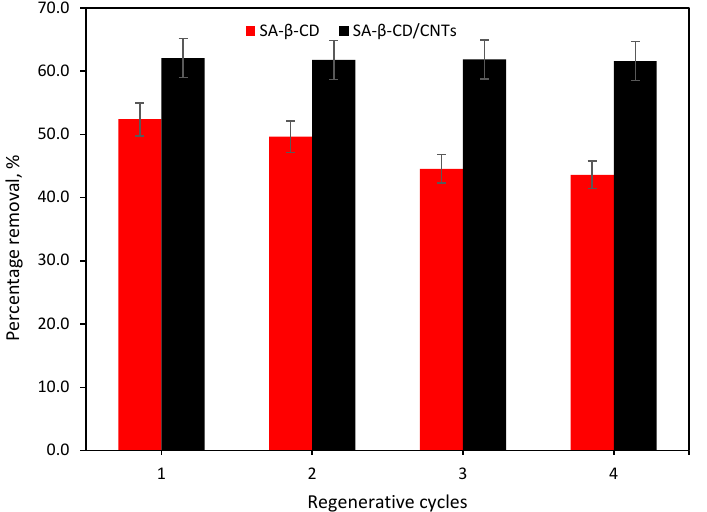
Figure 14. Regeneration cycles of SA − β − CD hydrogel and SA − β − CD/CNTs hydrogel Figure 14 . Regeneration cycles of SA −β− CD hydrogel and SA −β− CD/CNTs hydrogel adsorbent .